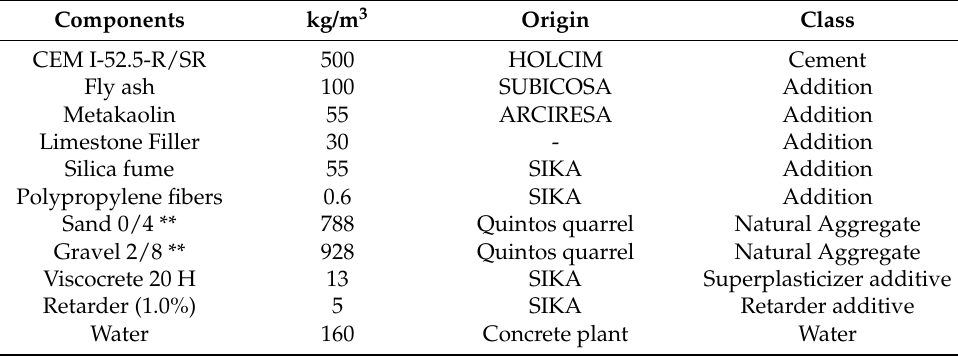
Table 5. High performance concrete